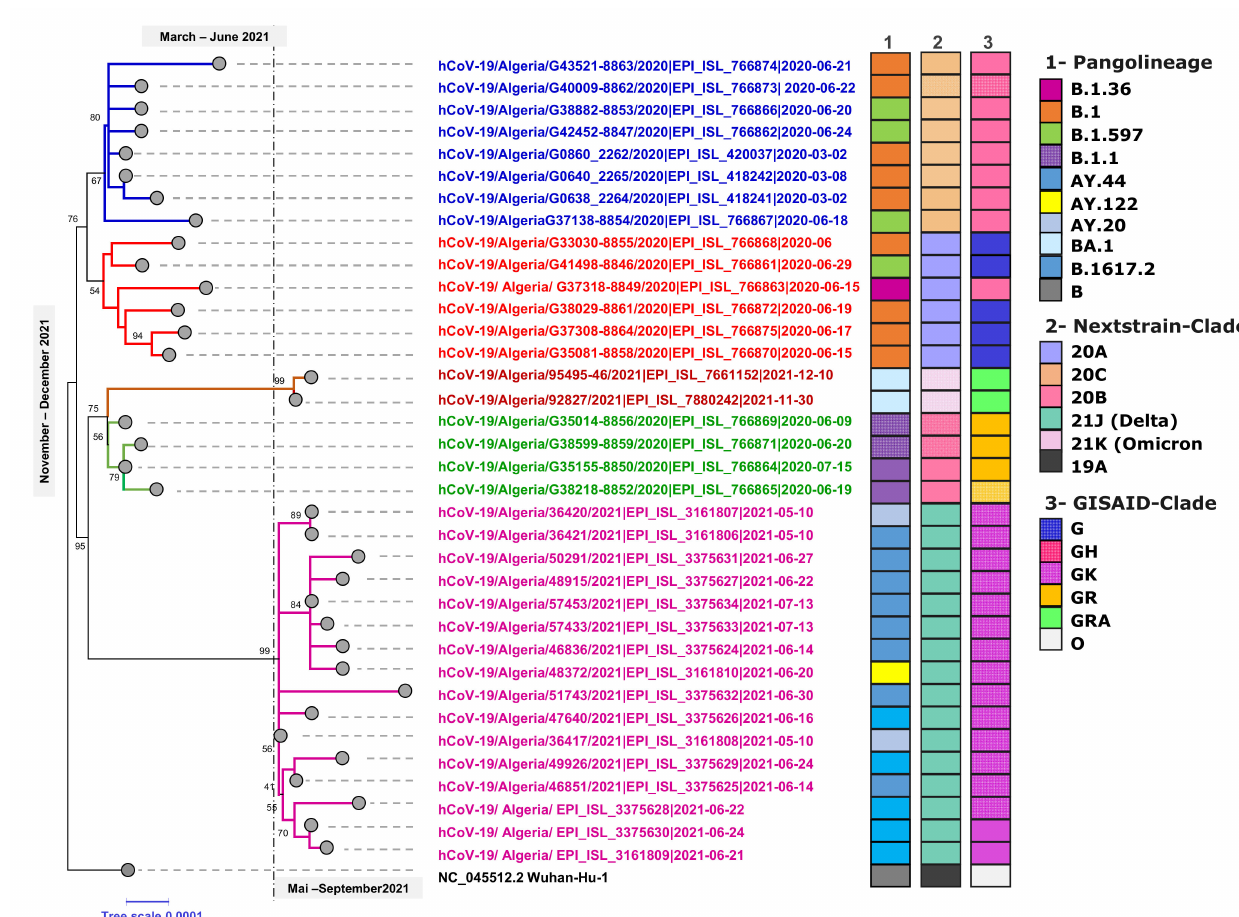
Figure 2. Rooted-Maximum likelihood phylogenetic tree of Algerian SARS-CoV-2 genome sequences (36 genomes). The genomes were classified into lineages using PANGOLIN clades, Nextclade and GISAID. The branch length on the phylogenetic tree represents the calendar time of sample collection: 18/36 samples were collected between March and June 2020, the 17/36 samples (21J—Delta) were collected late in May and July (2021) while the 2/36 samples were collected in November 2021 (21K-Omicron). The tree is rooted to the Wuhan reference genome